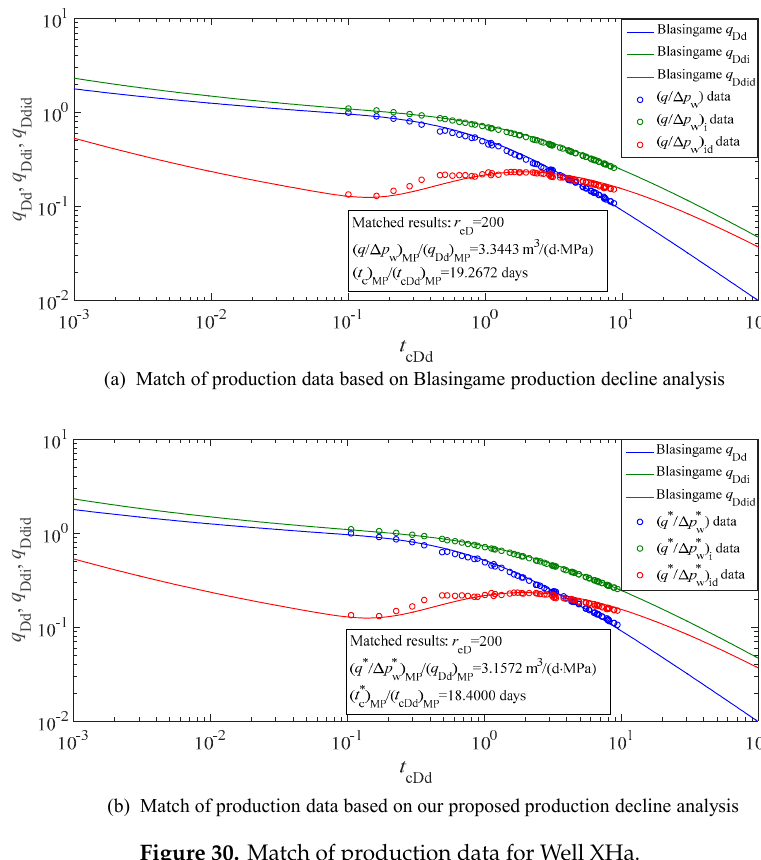
Figure 30. Match of production data for Well XHa. Table 13. Comparison between the results obtained by BPDA and PPDA for Well XHa.